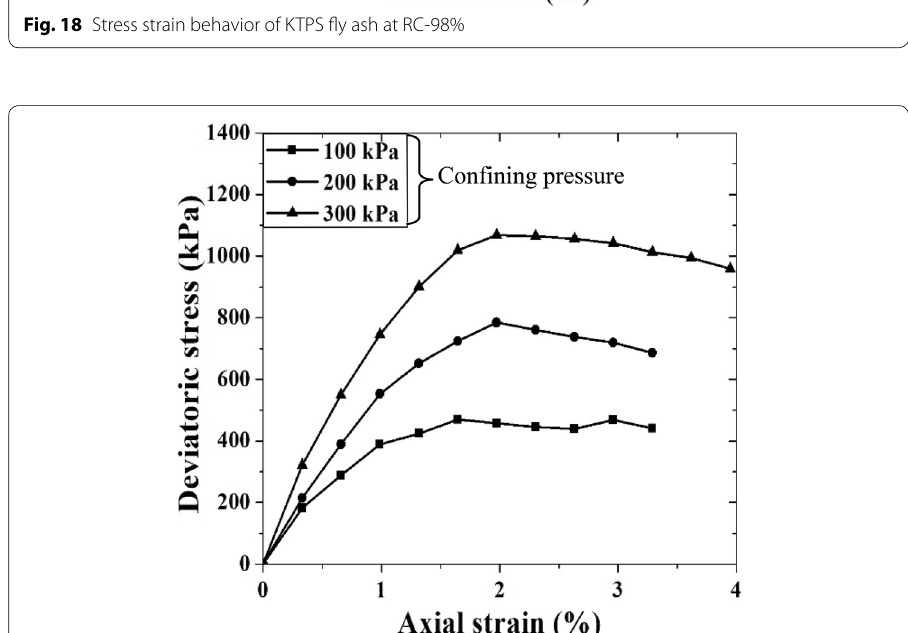
Fig. 19 Stress strain behavior of KTPS fly ash at